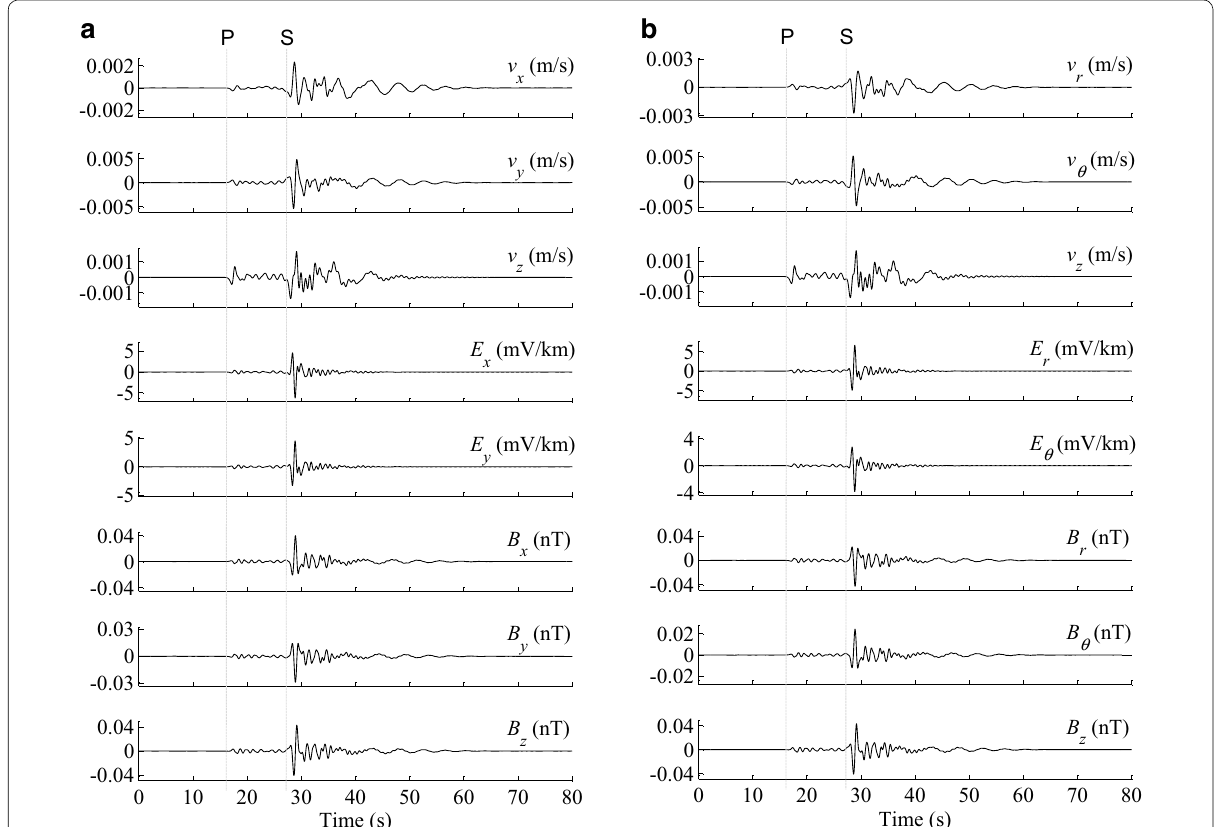
Fig. 9 Seismic and EM signals obtained by considering an artificial scattering effect. Once again, we consider the seven‑layer half‑space model and a receiver located at ( 80,890, 8680, 0.1) m. An artificial scattering effect is introduced by employing an artificial scattering conversion coefficient of − C st 0.6 and a horizontal wave‑field rotation angle of 30° in the counterclockwise direction. The simulated seismic and EM wave‑fields are displayed = in a Cartesian and b cylindrical coordinates,